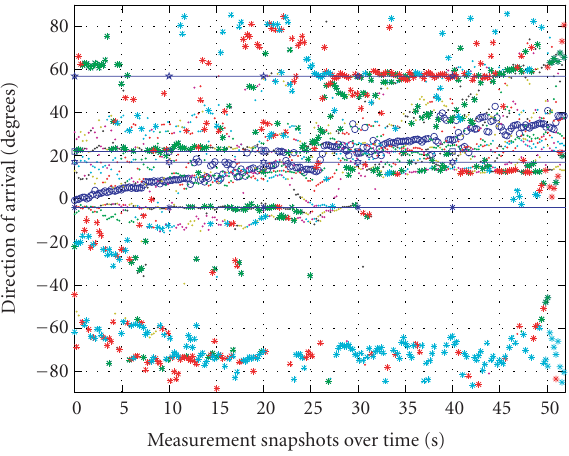
Figure 4: Estimates of propagation delay versus snapshots in time. Figure 5: Estimates of directions of arrival versus snapshots in